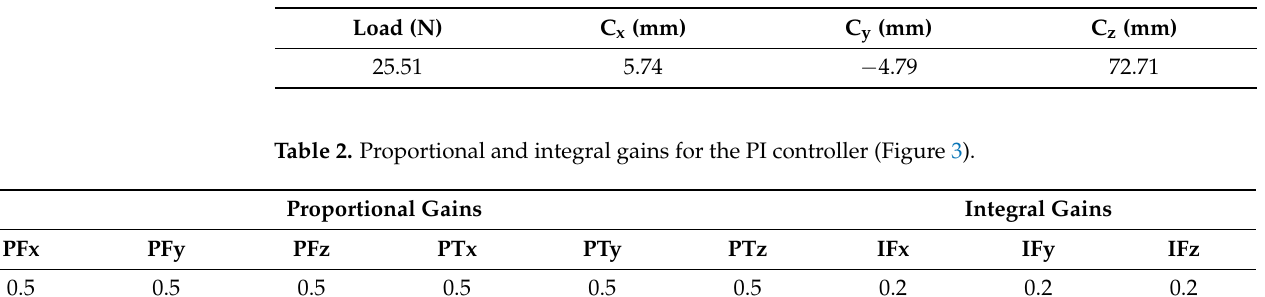
Table 1. Calibration of FT sensor based on end effector’s load and center of gravity.